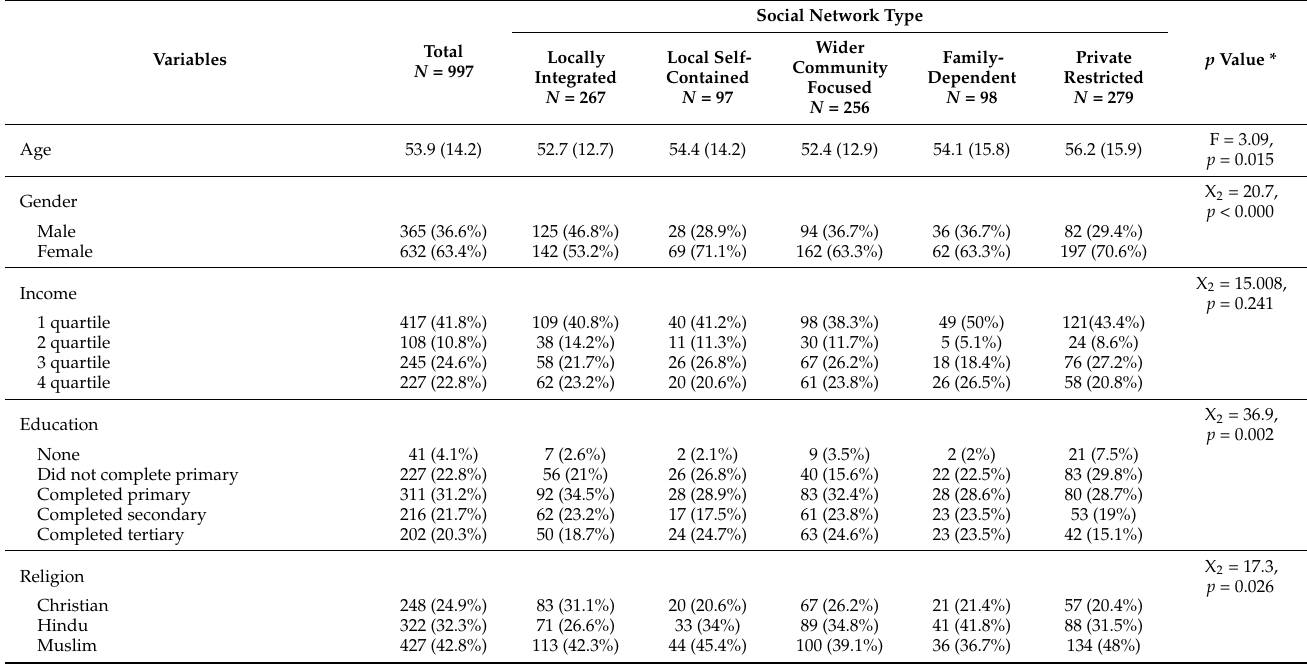
Table 1. Sociodemographic characteristics by social network